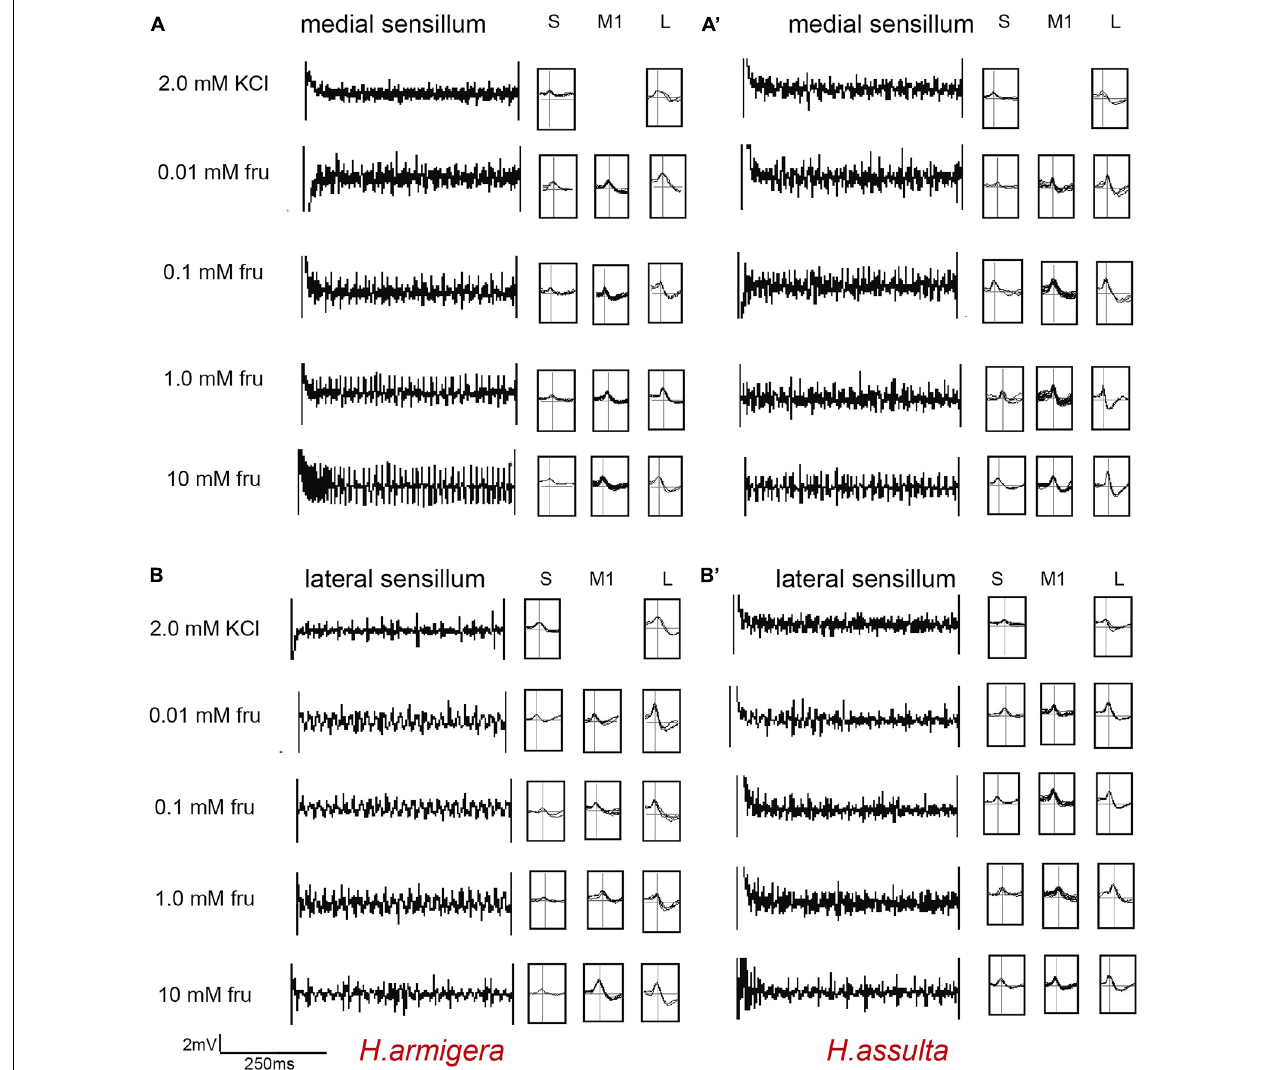
FIGURE 1 | Representative traces and indentified GRNs from responses of the medial and lateral sensilla of Helicoverpa caterpillars to fructose. “S,” “M1,” and “L” in H. armigera (A,A’) and H. assulta (B,B’) represent the identified GRNs from recording traces based on the analysis of AutoSpike software. The time duration of each trace is 500